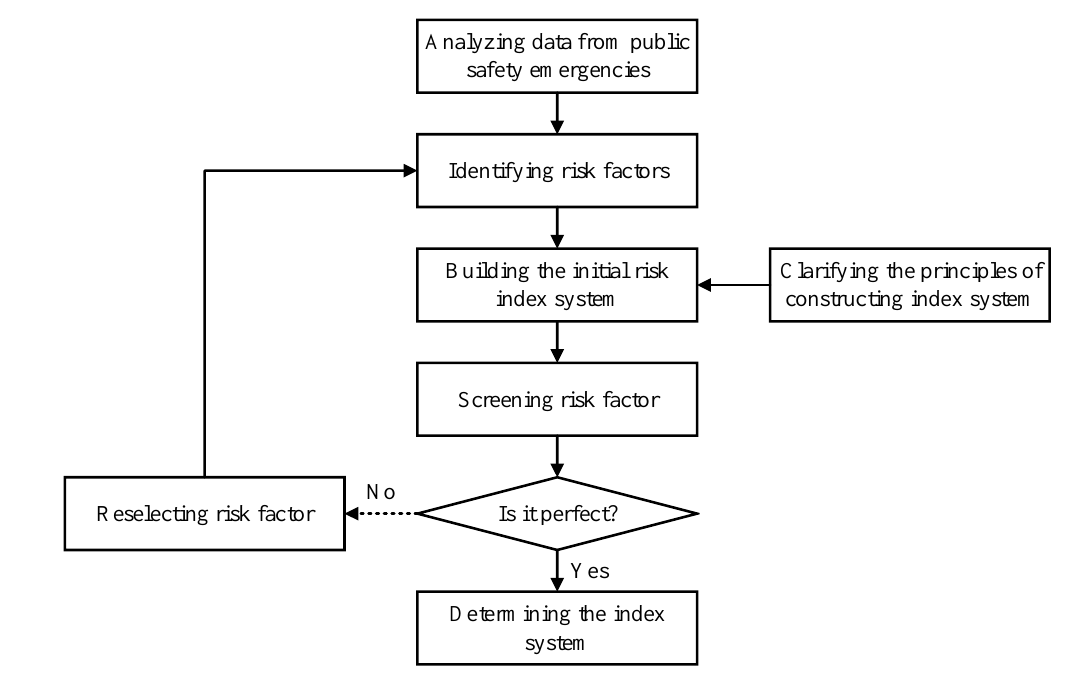
Figure 2. Steps of constructing index system.